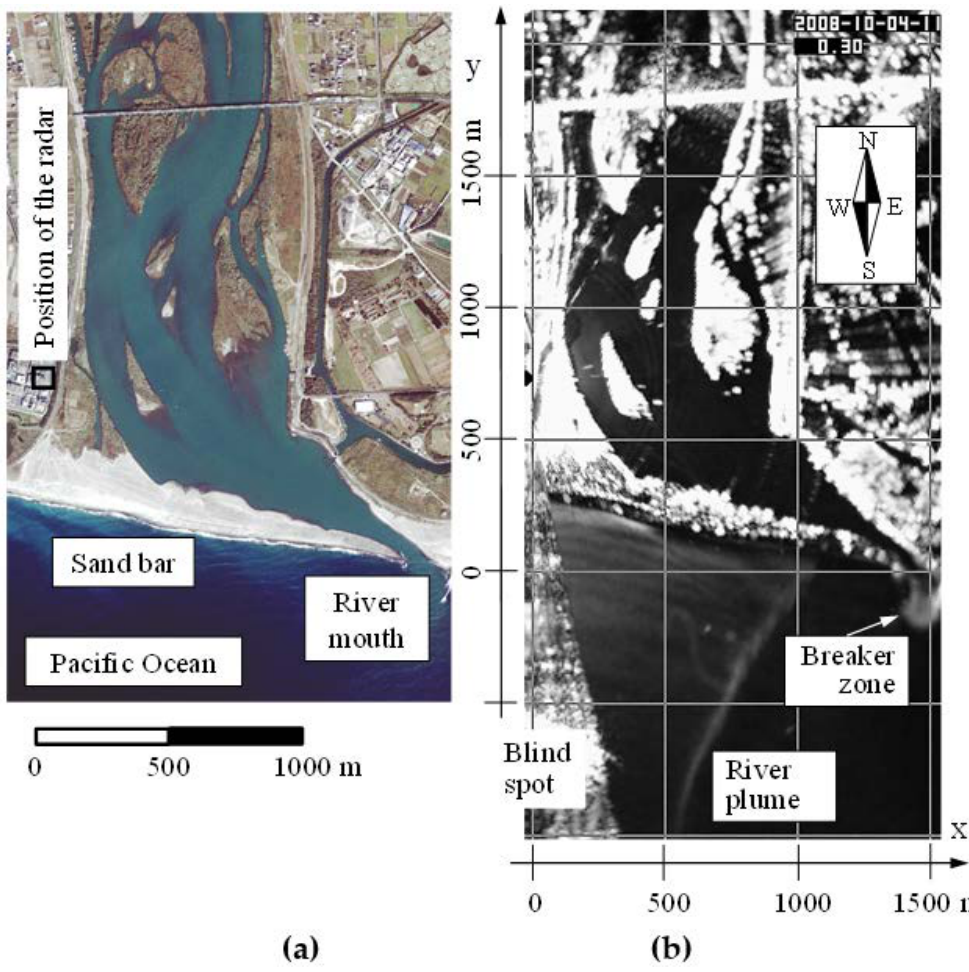
Figure 1. ( a ) Satellite visible image of the study area (True color composite display); and ( b ) time-averaged radar image. Satellite image: Ikonos-2. Acquisition date/time: 4 October 2008, 10:54 JST. Time-averaged radar image: average of images collected from 11:00 JST to 11:17 JST on 4 October 2008. Tide level of Omaezaki: 0.30 m (T.P.).